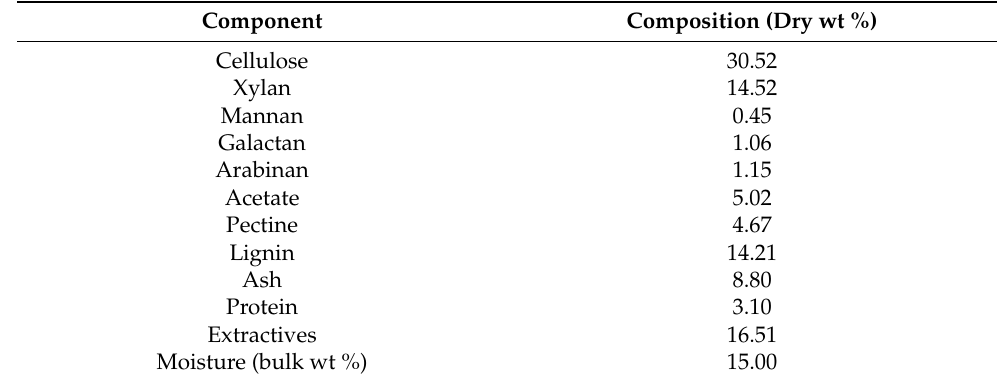
Table 1. Cardoon stalks composition used for process simulation.